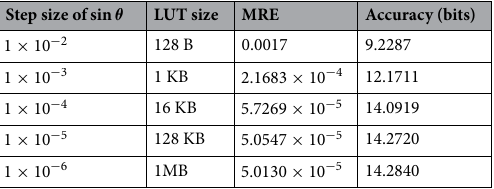
Table 5. The impact of the step size of sin θ on the accuracy results of our proposed square root algorithm, assuming a 16-bit precision of cos θ